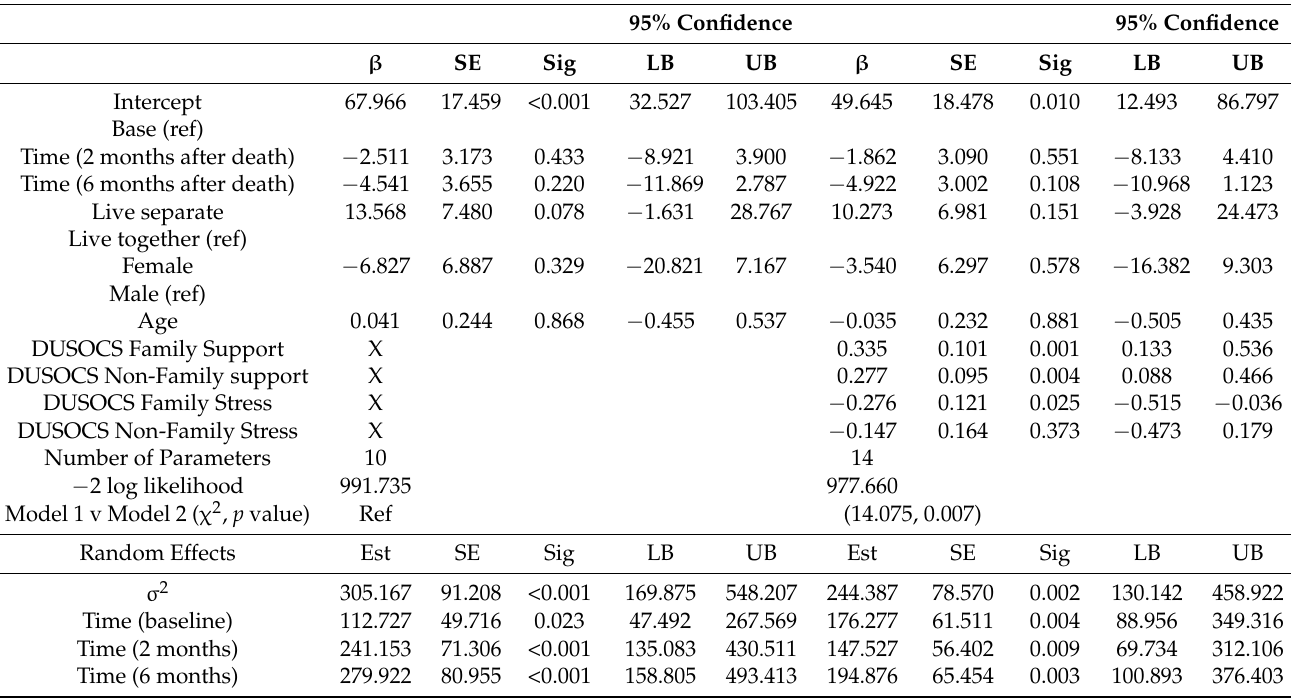
Table 3. Mixed effects modeling examining Family and Non-Family support and stress on General Social Support. Model 2: MOSS on DUSOCS Stress/Support Model 1: MOSS on Demographics